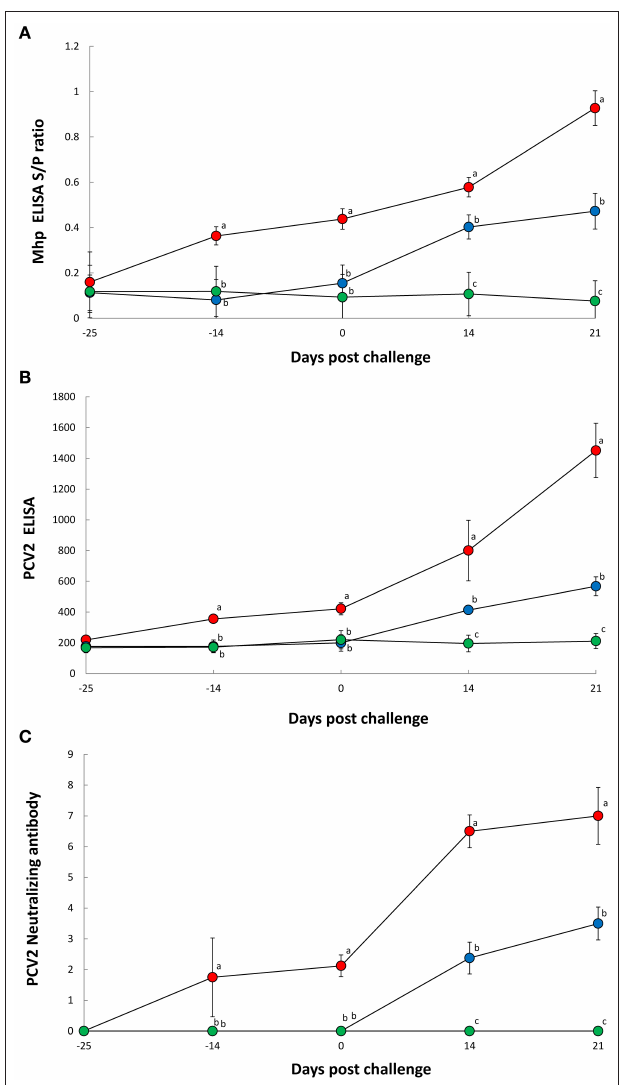
FIGURE 2 | ELISA antibody levels of Mycoplasma hyopneumoniae (A) , ELISA antibody levels of porcine circovirus type 2 (B) , and neutralizing antibody titers against porcine circovirus type 2b (C) in serum from Vac/Ch ( ), UnVac/Ch ( ), and UnVac/UnCh ( ) groups. Variation is expressed as the standard deviation. Different superscripts (a, b, and c) indicate significant ( P < 0.05) difference among three groups.